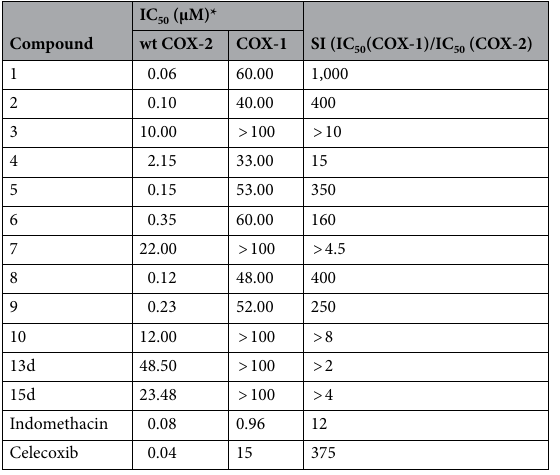
Table 2. IC 50 (μM) of the compounds for COX-2 and COX-1. *All the readings were average of 3 experiments with SD ± 0.5